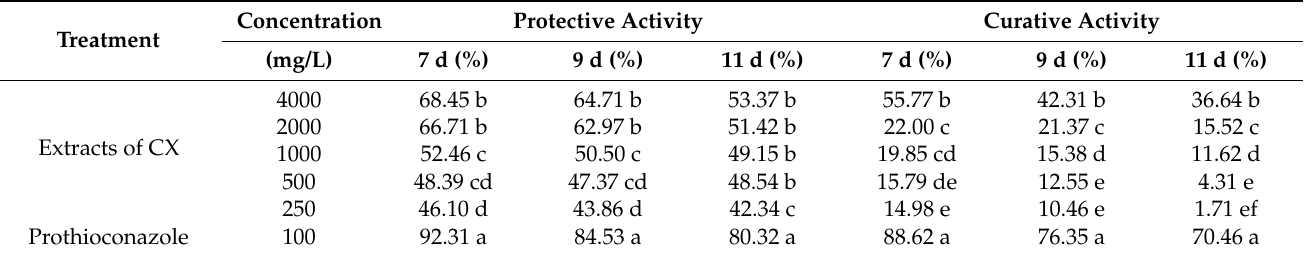
Table 2. Control effect of CX extract on Blumeria graminis by pot trial.